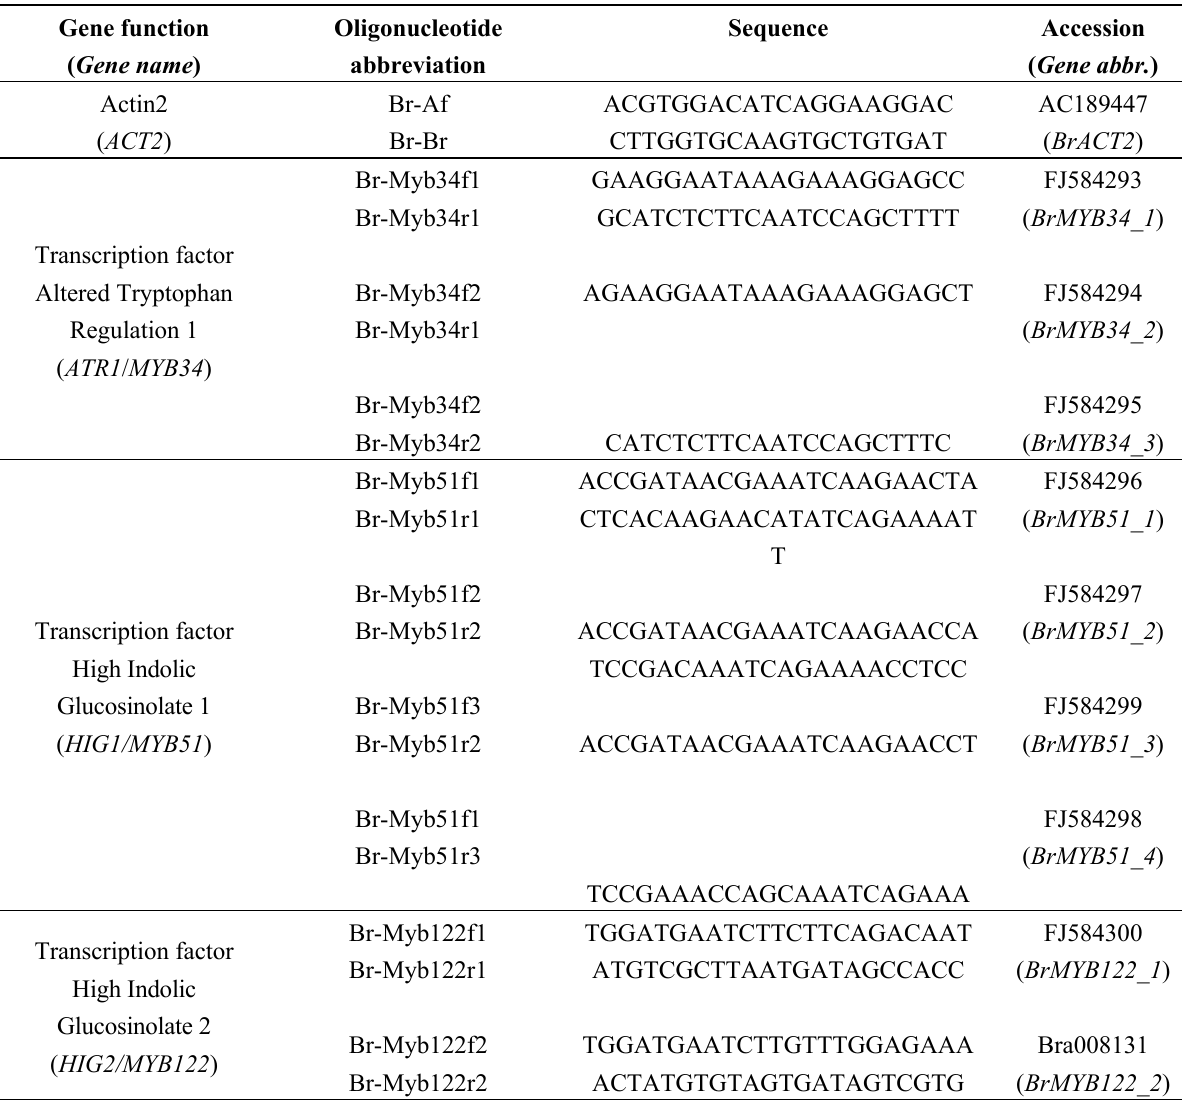
Table 1. Oligonucleotide primers used for gene expression analysis by semi-quantitative realtime